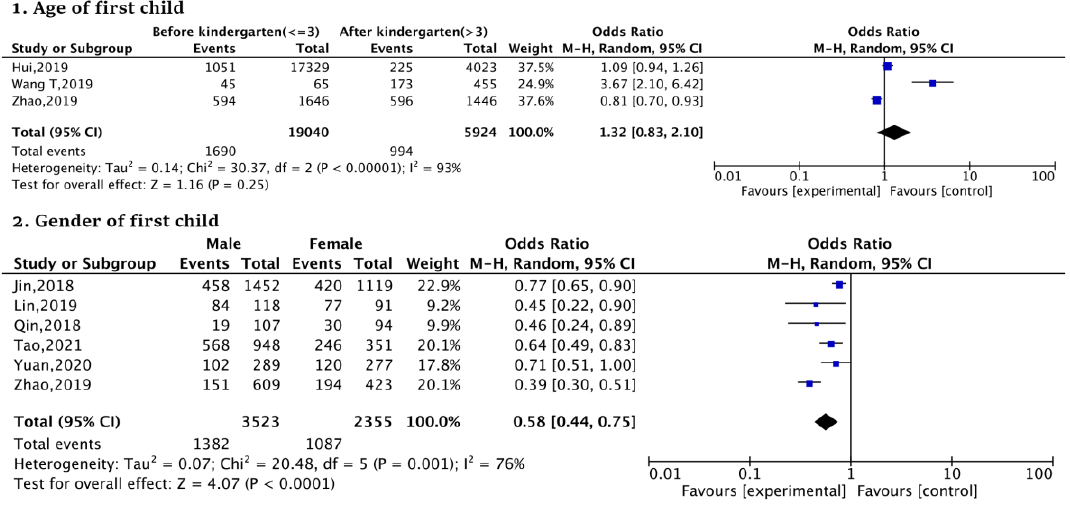
Figure 5. Forest plots of children factors [20,46,49–51,54–56].